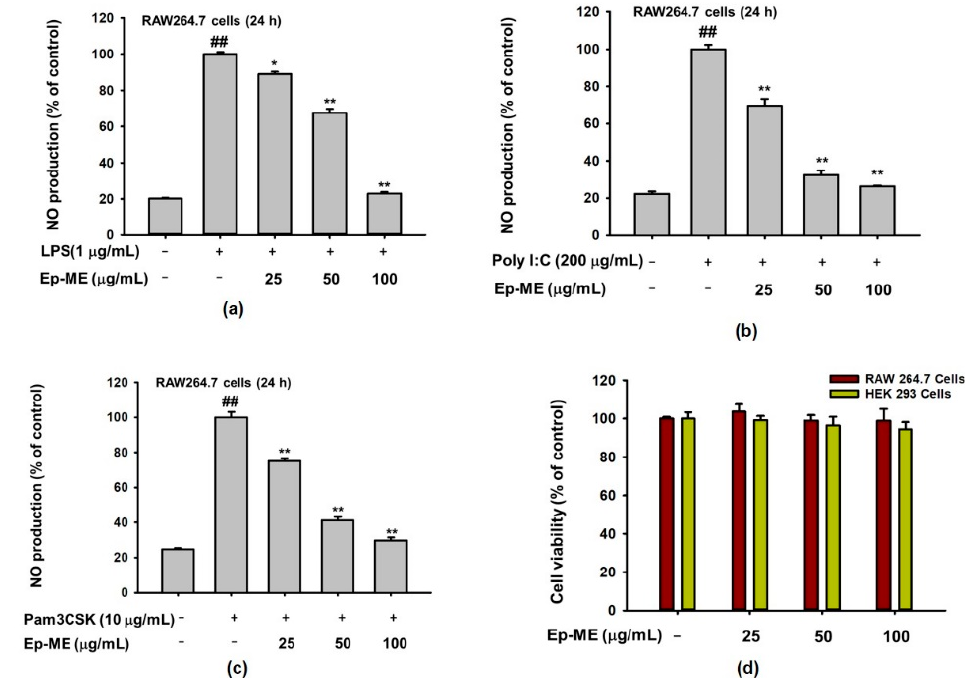
Figure 1. The effects of Euodia pasteuriana methanol extract (Ep-ME) on the production of nitric oxide (NO). The level of NO production in the culture supernatant of RAW264.7 cells treated with ( a ) lipopolysaccharide (LPS) (1 μ g/mL), ( b ) polyinosinic-polycytidylic acid (poly I:C, 200 μ g/mL), or ( c ) Pam3CSK (10 μ g/mL) with or without Ep-ME for 24 h. ( d ) The cytotoxic effects of Ep-ME against RAW264.7 cells and HEK293T cells after incubation for 24 h. Data are presented as mean ± SD ( n = 3). ## p < 0.01 vs. untreated control group, * p < 0.05, and ** p < 0.01 vs. LPS group.